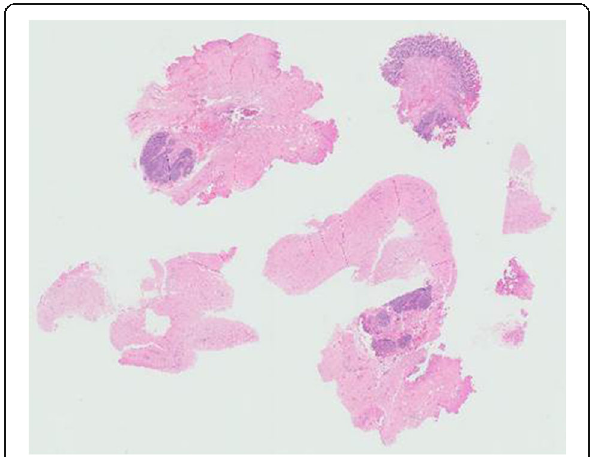
Fig. 1 Ultrasound findings. There was a tubular structure ( black arrow ) traced from umbilicus with possible connection to the urinary bladder ( hollow arrow )